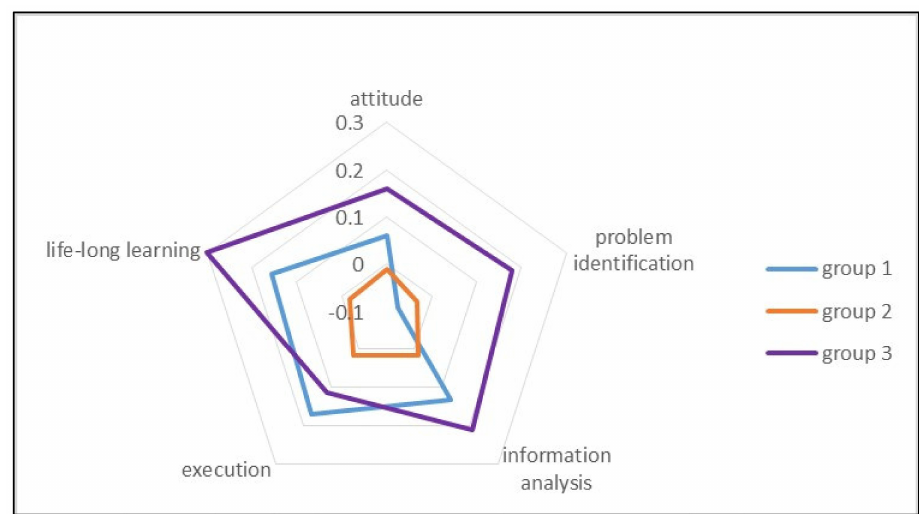
Figure 1. The radar chart comparing the changes in the core competencies.